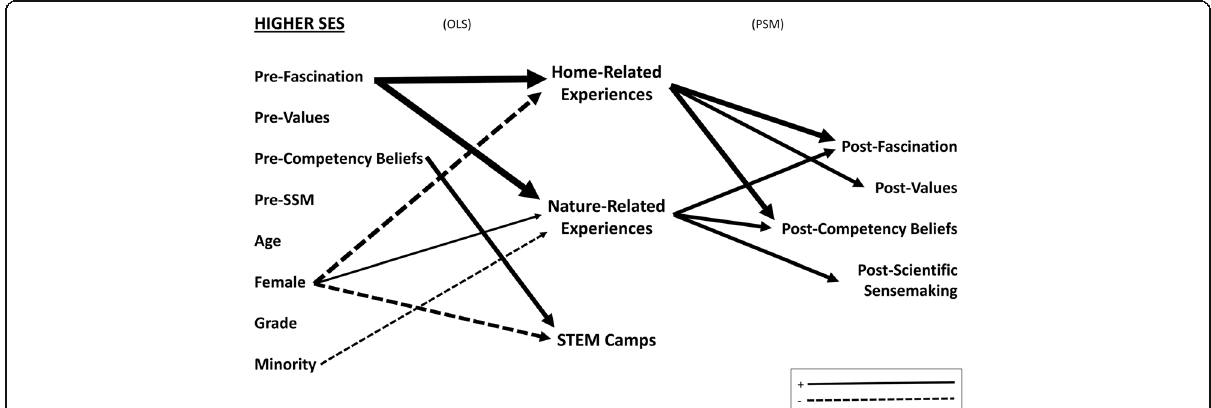
Fig. 3 Summary of characteristics that influence optional summer science experience participation (from the OLS models of participation) and how participation influences post-summer outcomes (from the PSM models of impact) for Higher SES